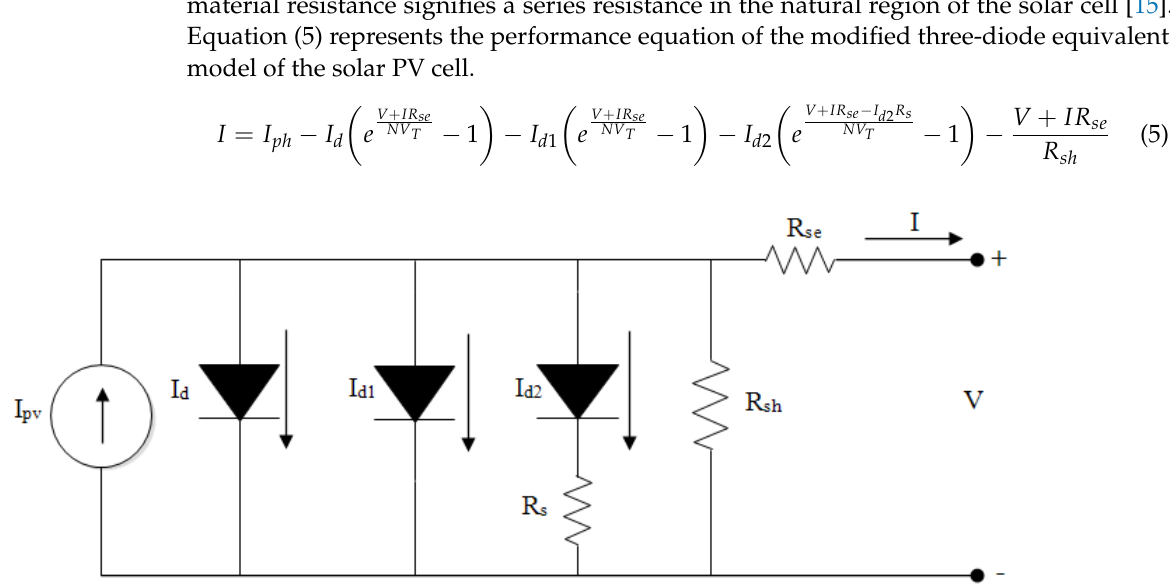
Figure 4. Schematic diagram of the modified triple-diode PV model.